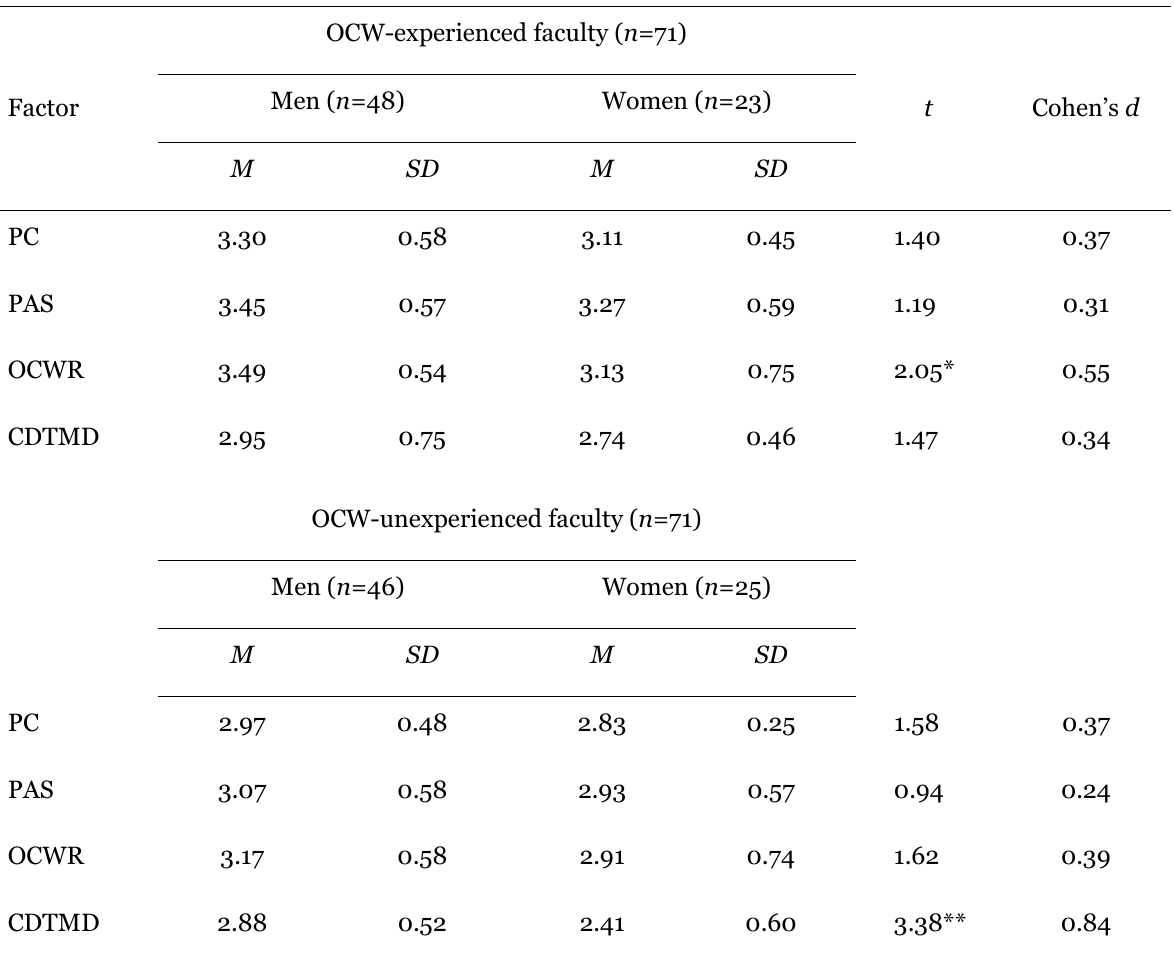
Descriptive Statistics and t-Test of Gender on TRS-OCW Factors